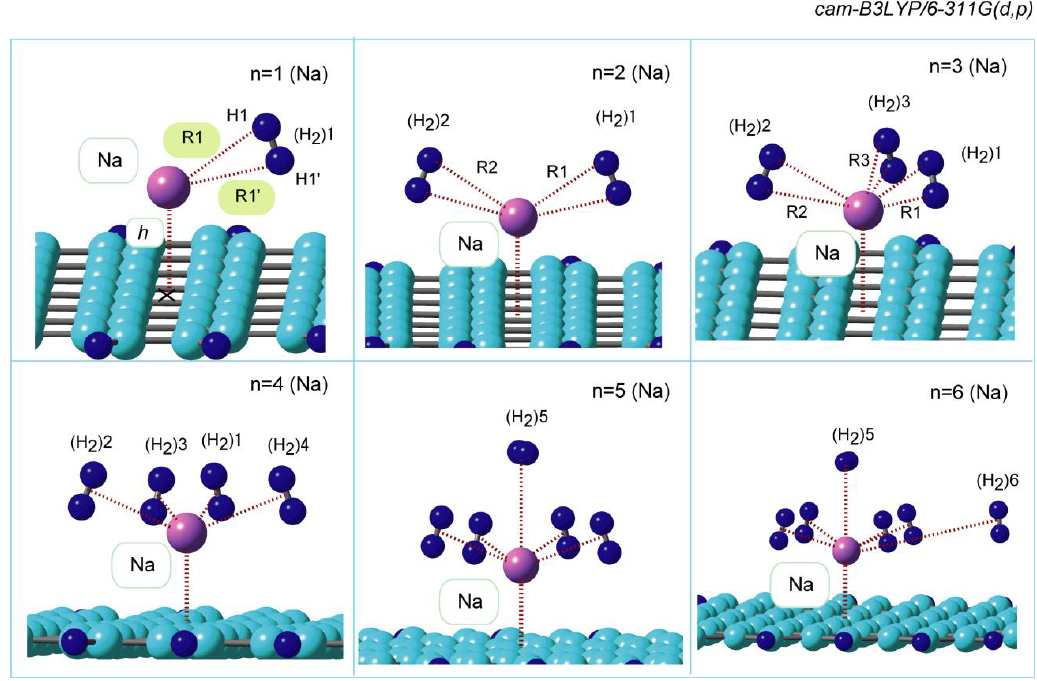
Figure 4. The optimized structures of GNF(37)–Na(atom)–(H 2 ) n ( n = 1–6). The calculations were performed at the CAM-B3LYP/6-311G(d,p) level. Reprinted with permission from [39].